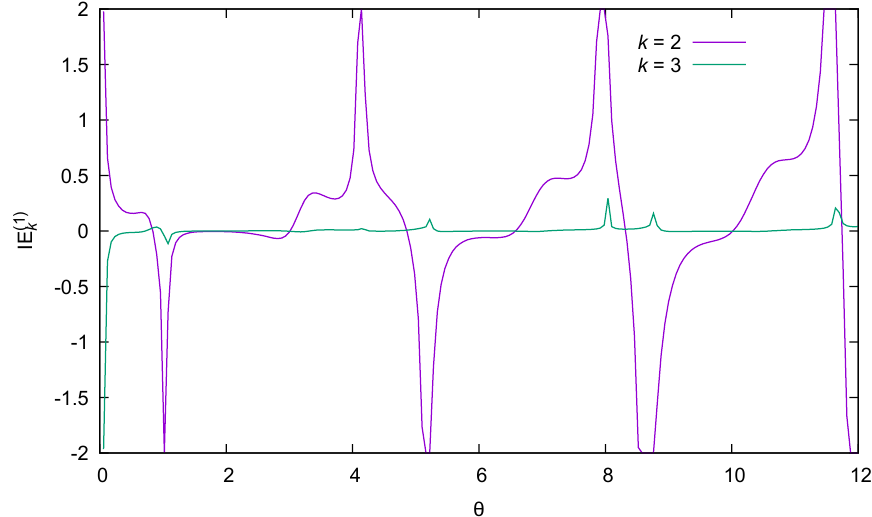
Figure 7. Scaled iteration differences calculated using Equation (35) for m = 1 for the parameters ε 1 = 0.1, ε 2 = 0.02, α = 1, β = 1, γ = 1.5, κ = 0.1, n = 4 and δ = 0.9. Trajectories used in these calculations were started from ( e , s , c ) = ( 0,0,0 )